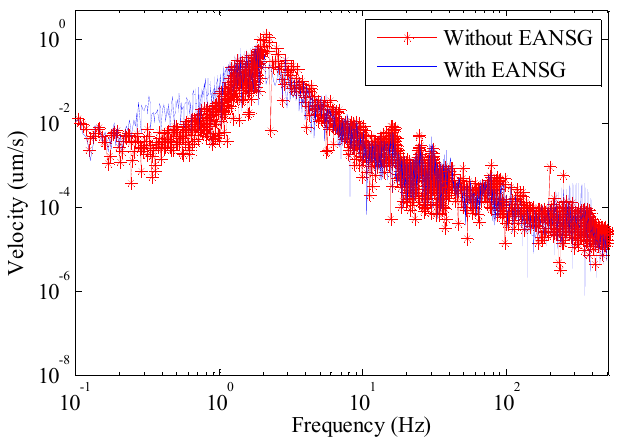
Figure 22. Spectrum analysis of velocity.